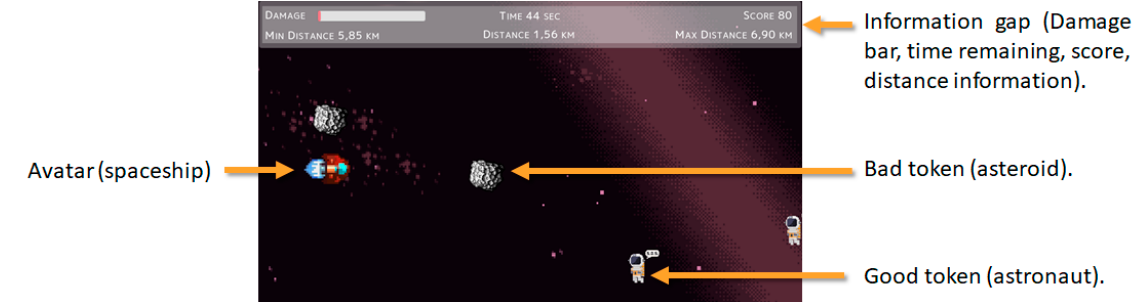
Figure A2. Game interface with the player’s avatar and different tokens deployed. The information gap is located in the upper part of the screen containing information about the spaceship’s damage, time remaining, the score, the distance traveled and an upper and a lower distance threshold (game mechanics). Table A1. Level characteristics (* compared to normal level).